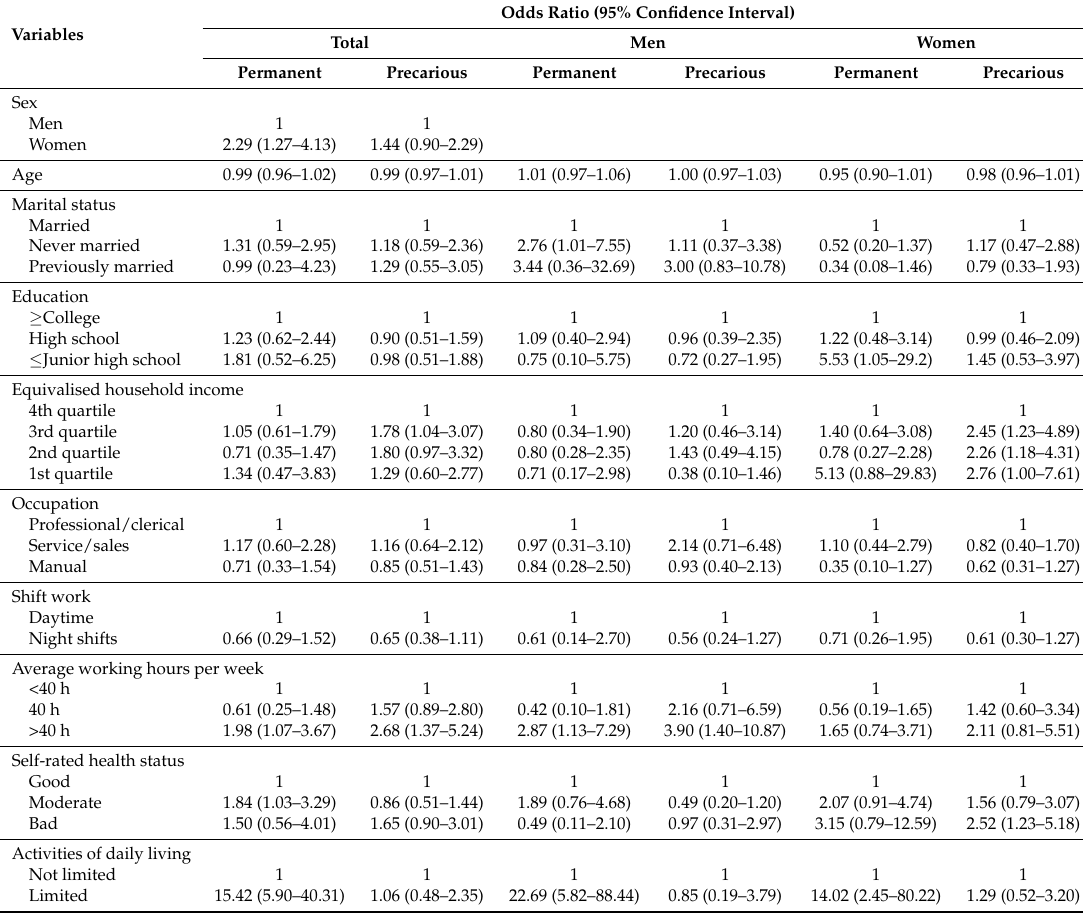
Table 3. Factors associated with self-reported unmet healthcare needs by employment status and